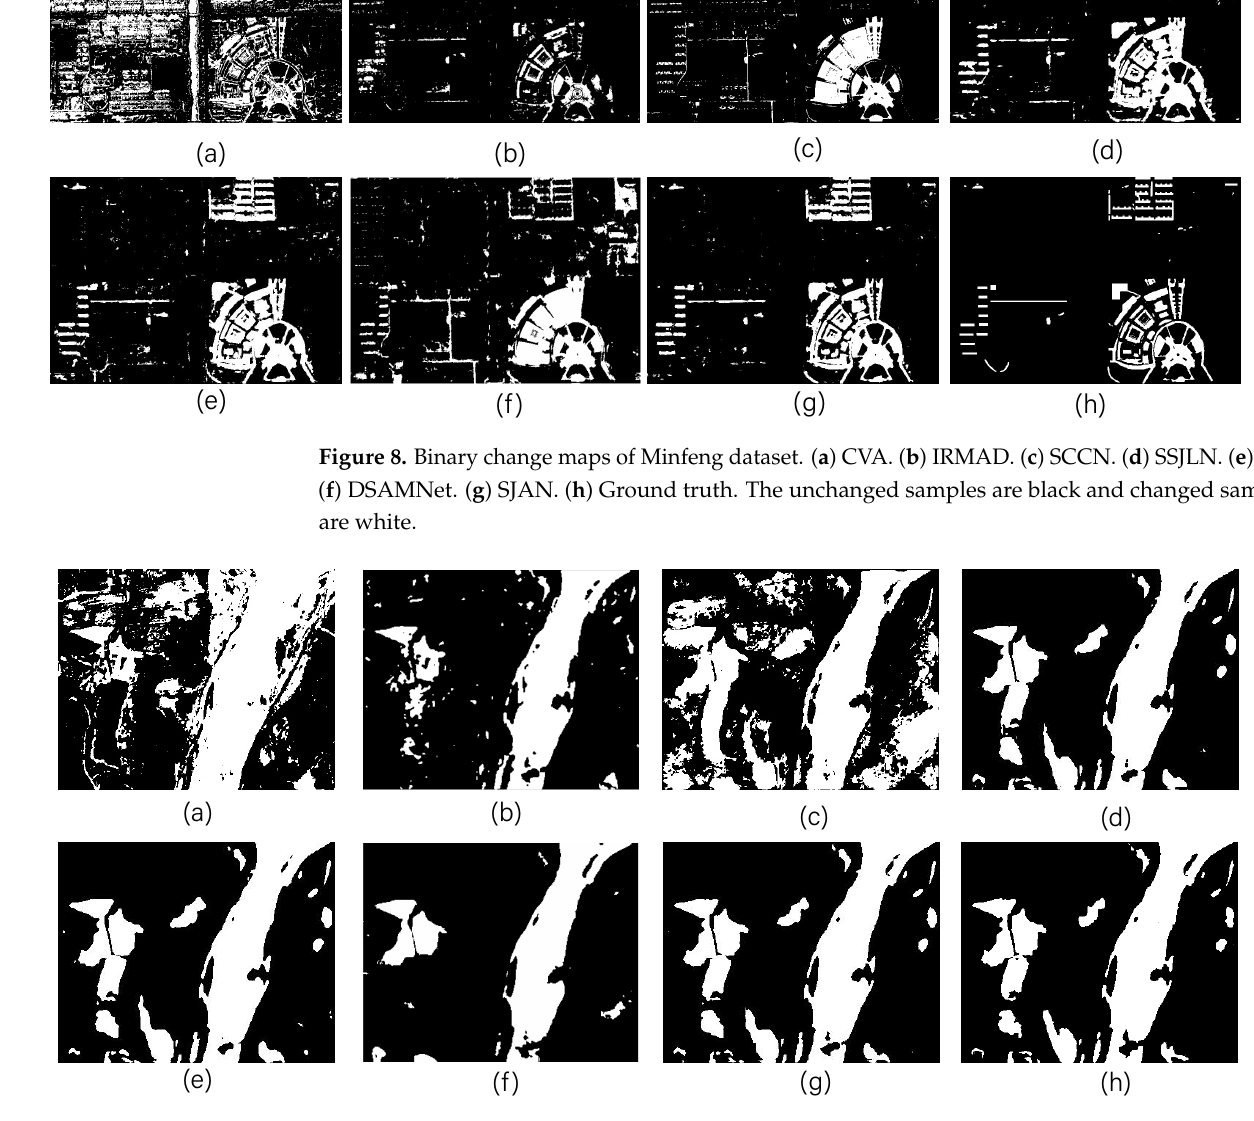
Figure 9. Binary change maps of Weihe River dataset. ( a ) CVA. ( b ) IRMAD. ( c ) SCCN. ( d ) SSJLN. ( e ) STA. ( f ) DSAMNet. ( g ) SJAN. ( h ) Ground truth. The unchanged samples are black and changed samples are